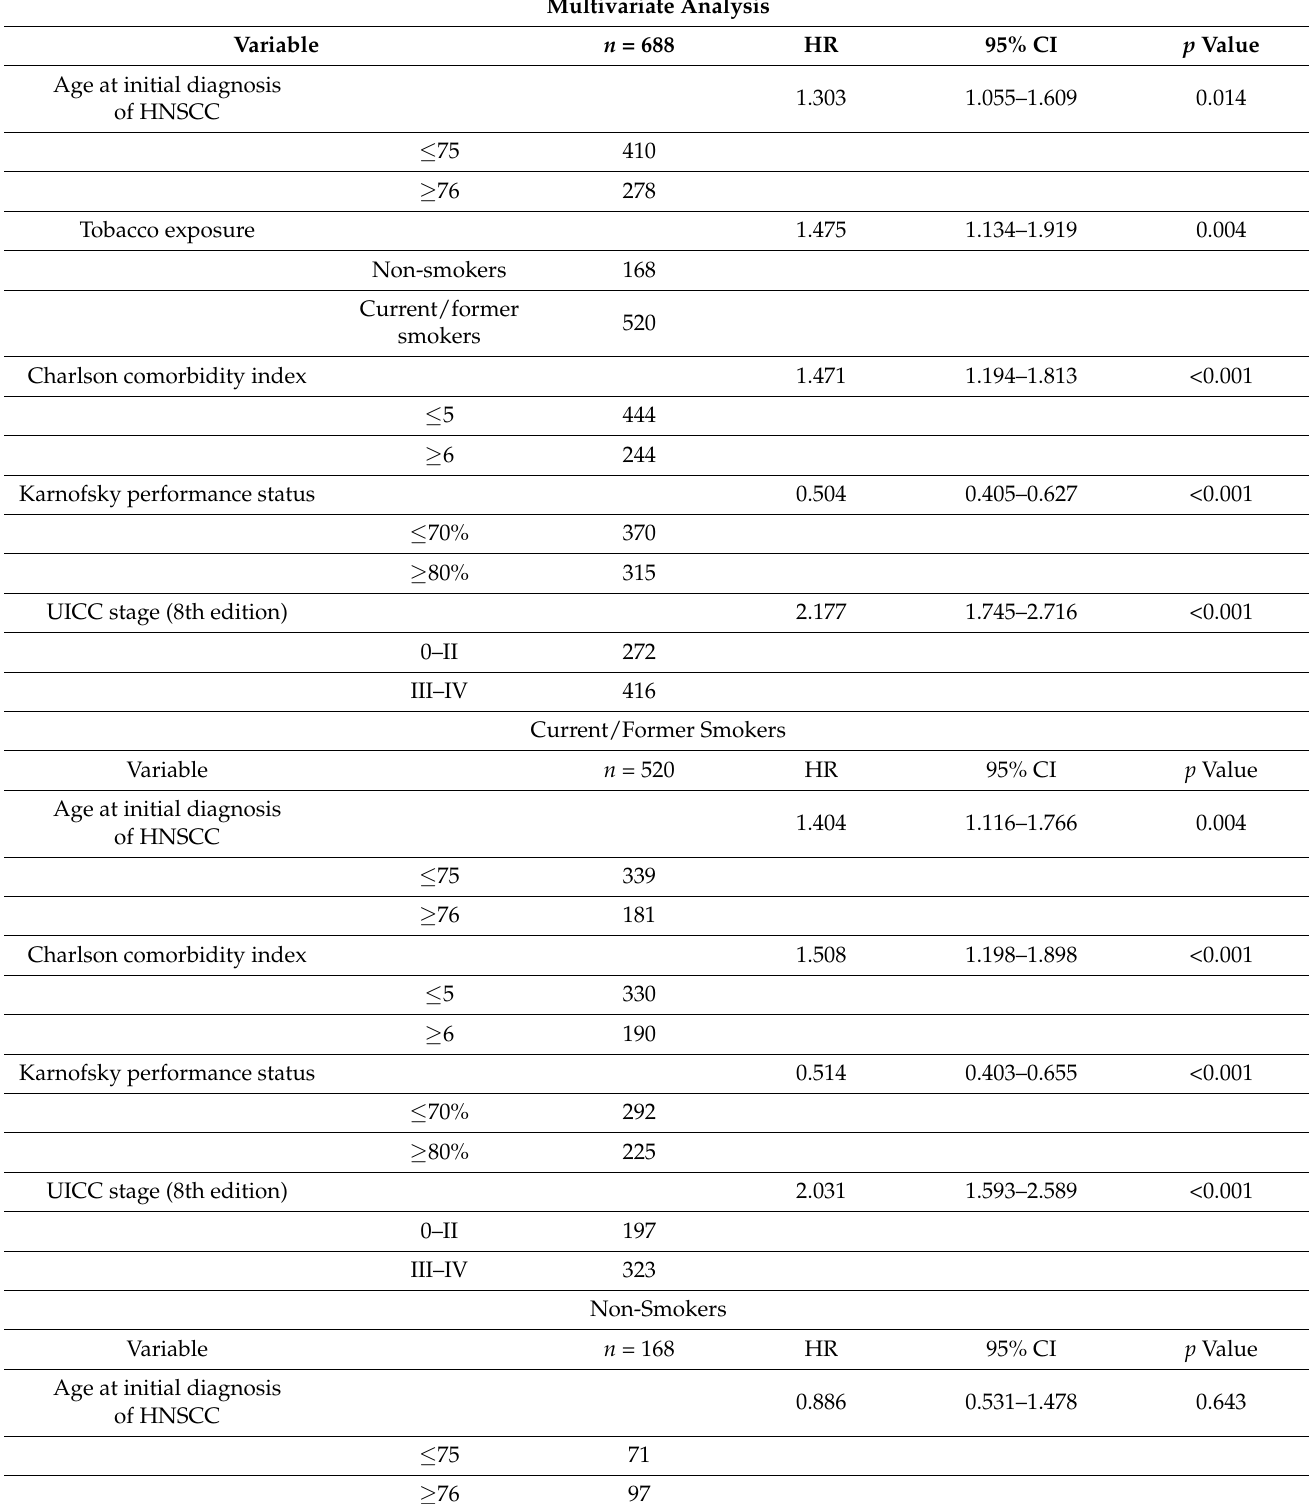
Table 4. Multivariate analysis of clinicopathologic variables associated with overall survival. Multivariate